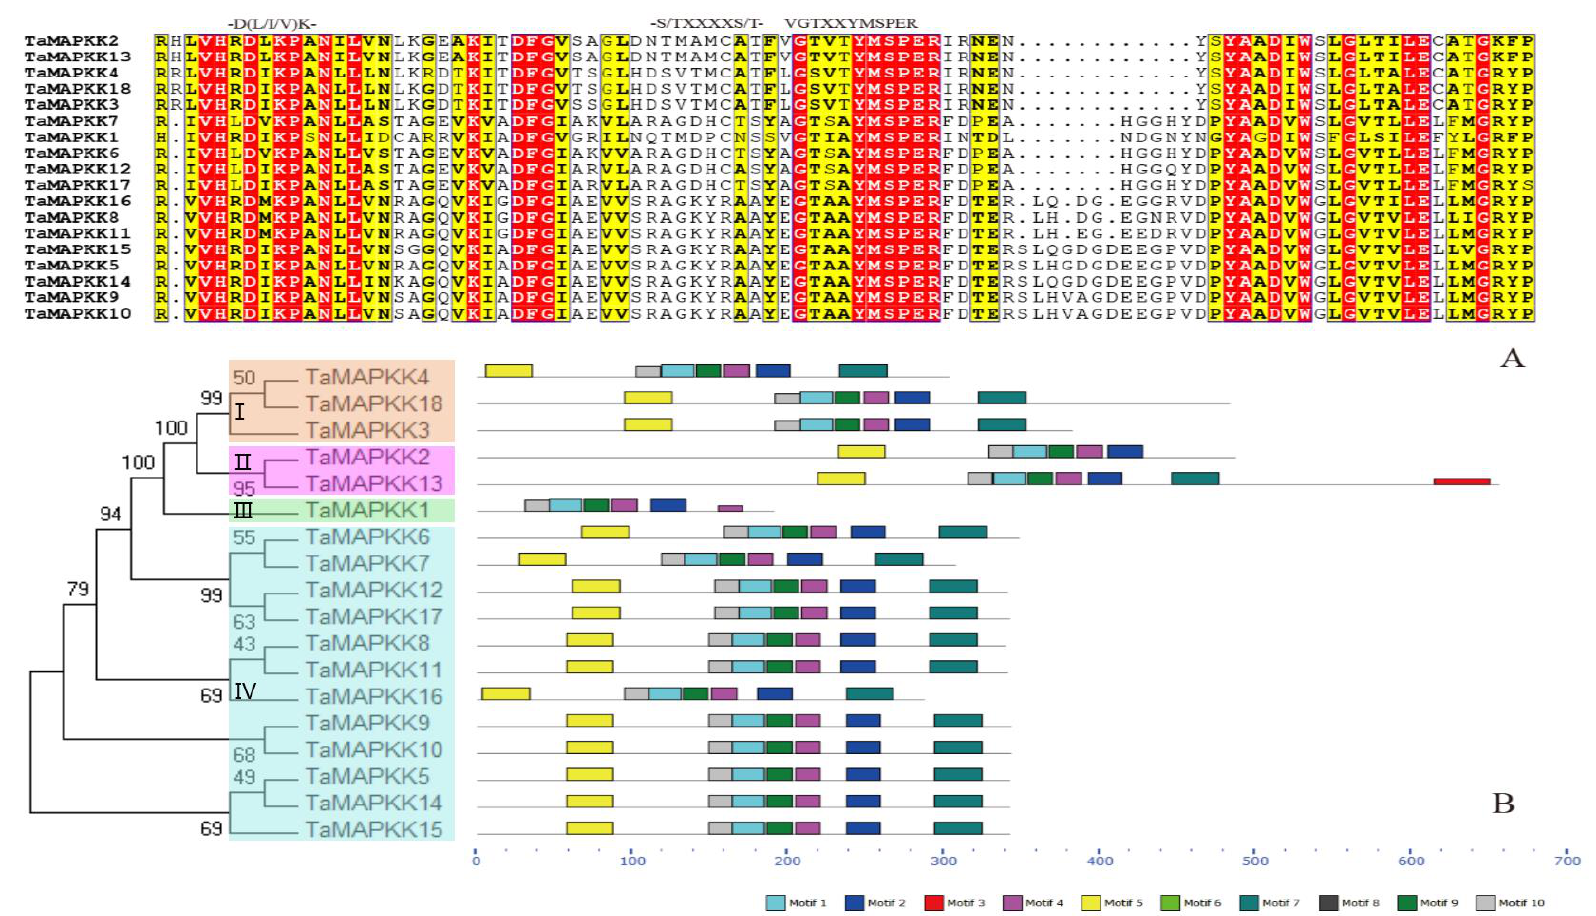
Figure 2. Phylogenetic relationship and conserved motifs compositions of the wheat MAPKK family. ( A ) Multiple alignments and conserved signature motifs found in the protein sequences of wheat MAPKK family; ( B ) Phylogenetic analysis (left) and conserved domain compositions (right) in wheat MAPKK family. The unrooted phylogenetic tree was constructed by MEGA 6.0 using the neighbor-joining method and the bootstrap test method with 1000 replications. Conserved motifs were predicated by MEME tool and each motif was represented with different colored boxes.